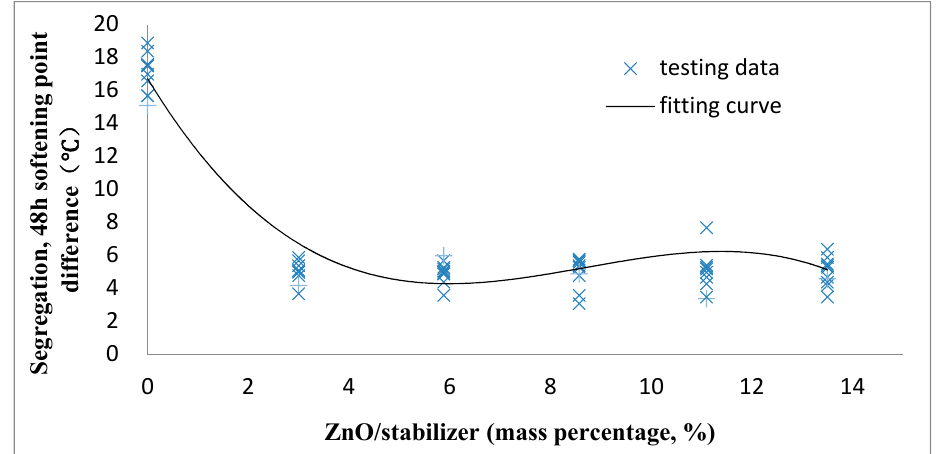
Figure 6. The 48-h segregation softening point difference with different ZnO content.